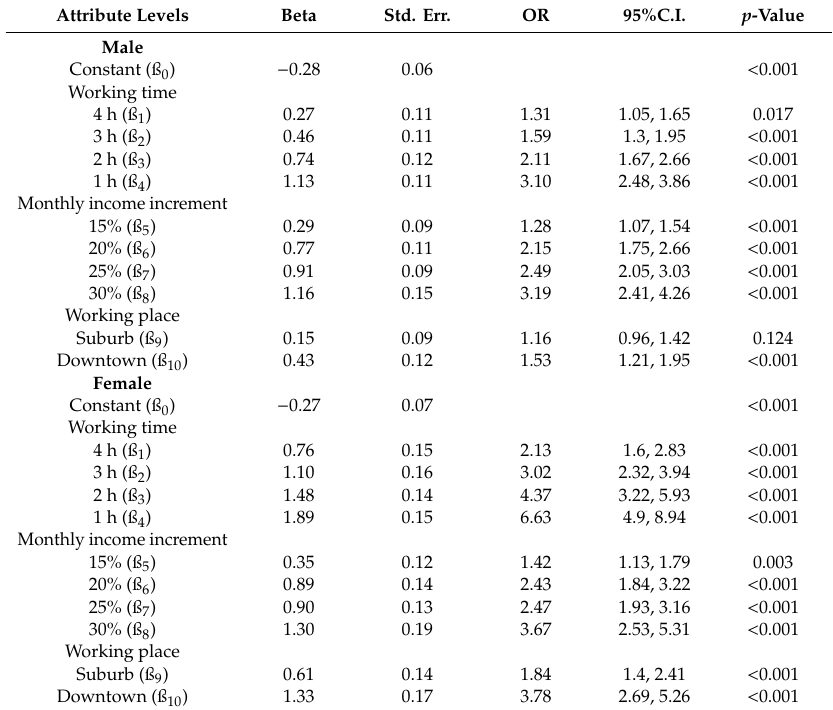
Table 6. Sub-group e ff ect model stratified by sex.